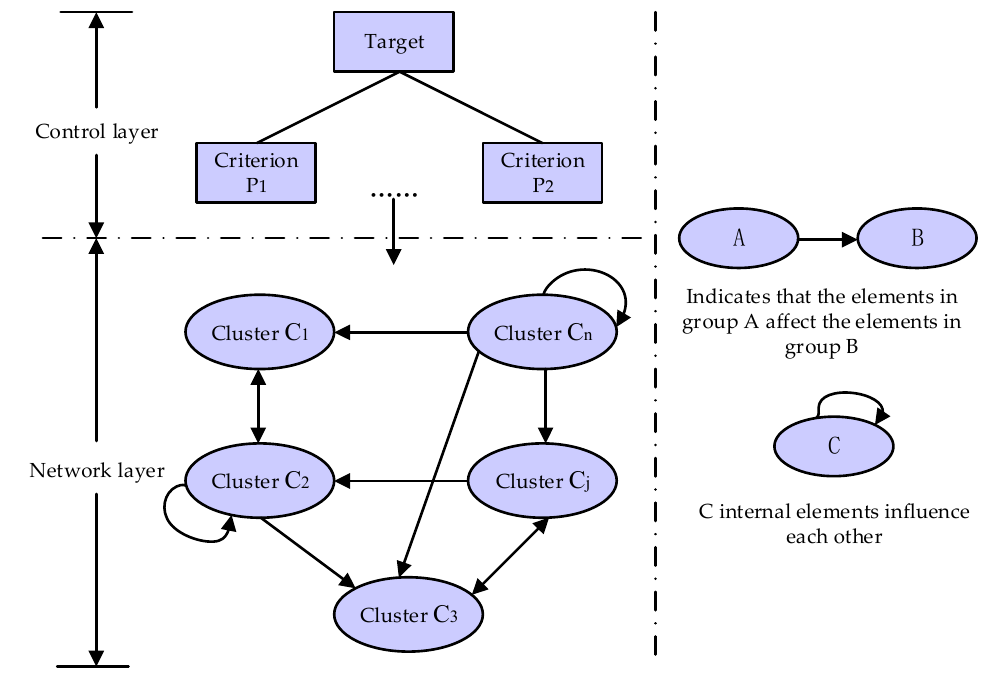
Figure 3. Typical ANP